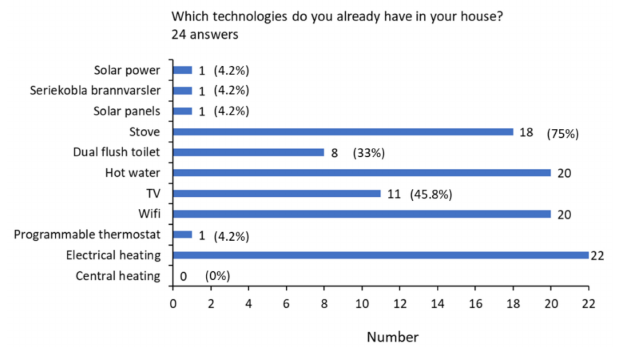
Figure 21. The technologies available in the respondents’ houses.